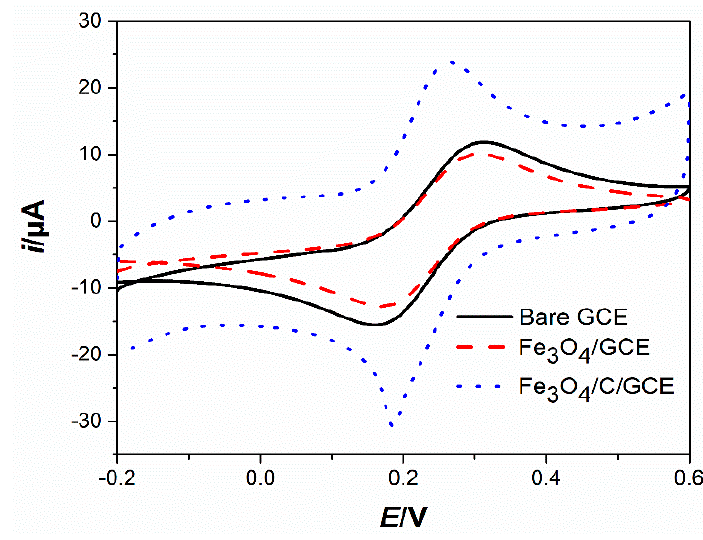
Figure 3. Electrochemical active areas of different electrodes were investigated by CV in 0.1 M PBS containing 0.5 mM of K 3 [Fe(CN) 6 ].